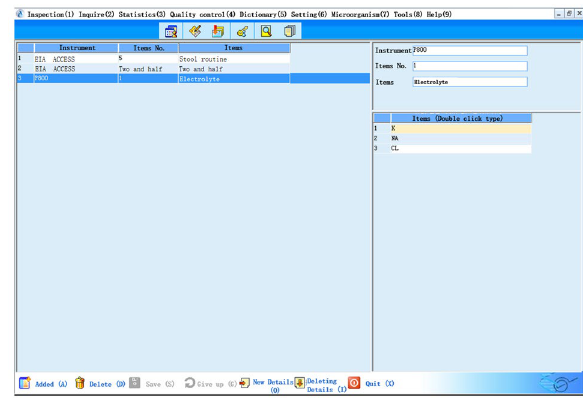
Fig. 4 Main interface of LIS360 system